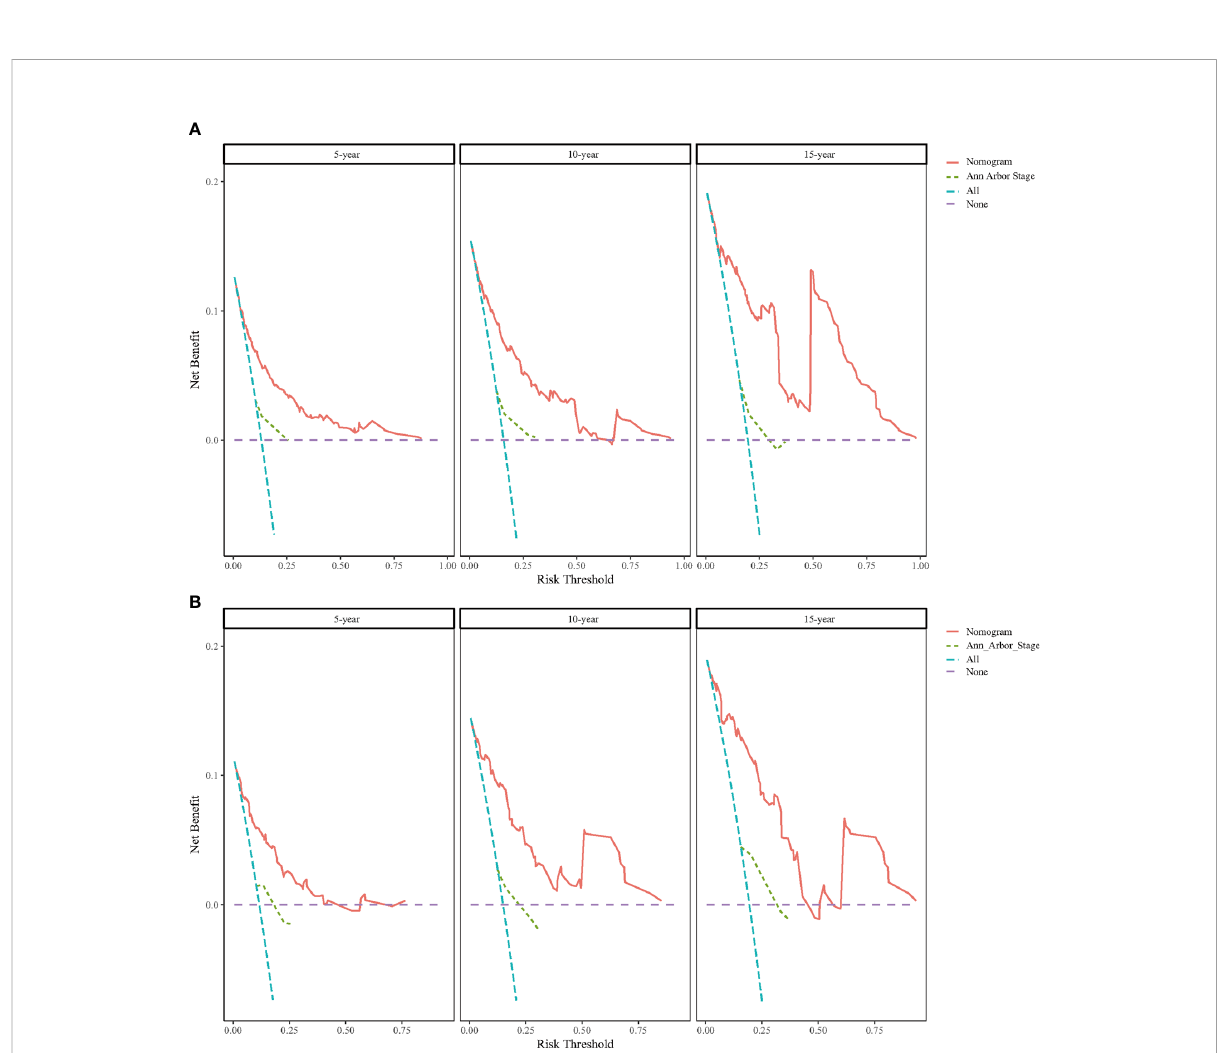
FIGURE 6 Decision curve analysis (DCA) for predicting BC-PTML-speci fi c survival at 5-, 10-, and 15-years in the training (A) and (B) validation